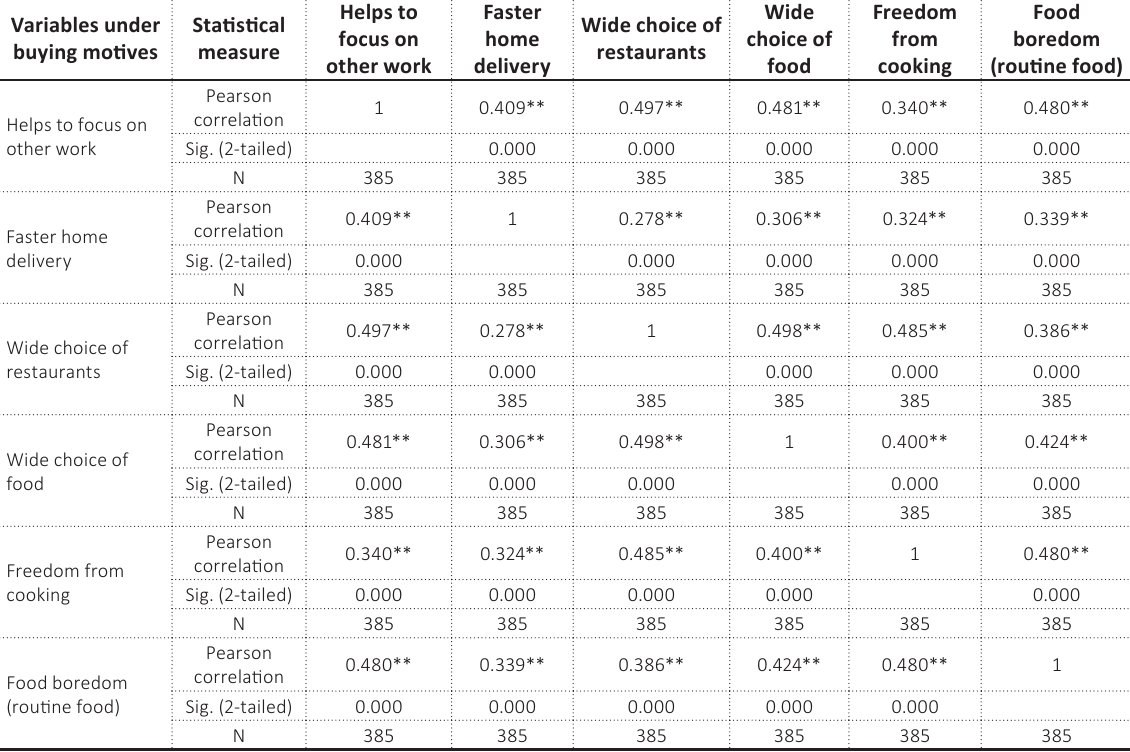
Table 3. Correlation of variables under buying motives Variables